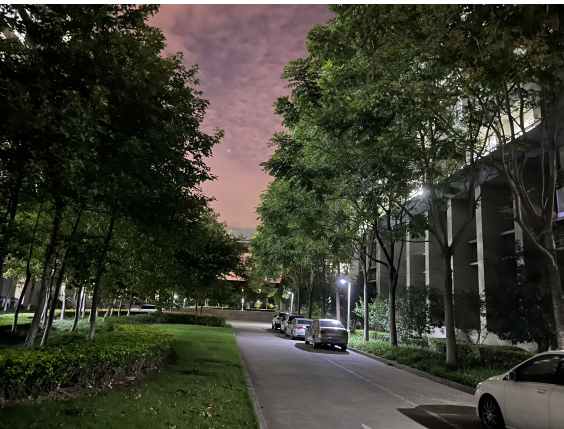
Figure 9. The scene of the outdoor environment.